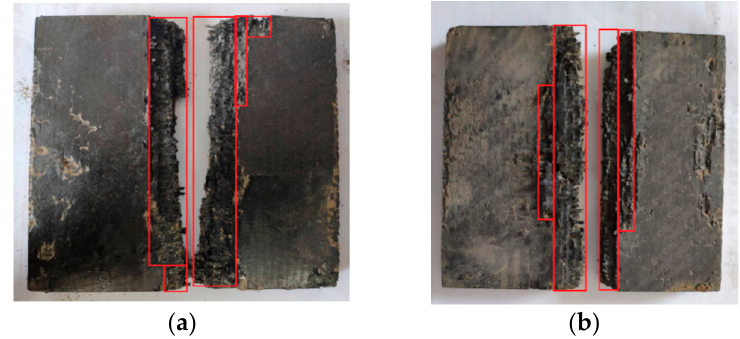
Figure 7. Schematic diagram of surface damage. ( a ) 15 mm; ( b ) 25 mm.